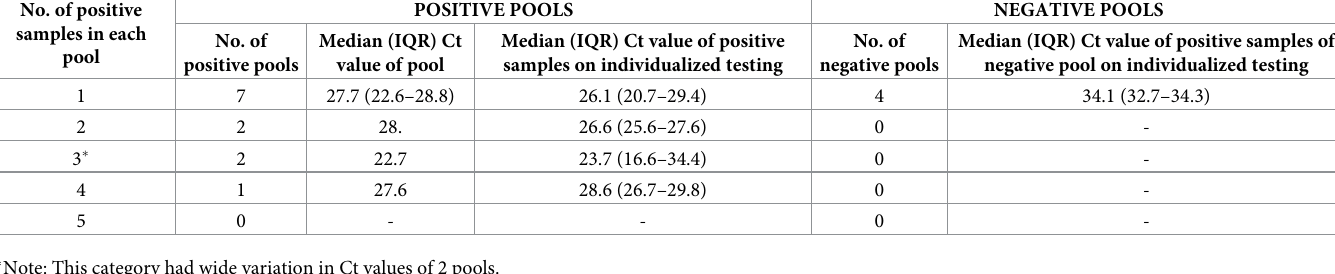
Table 1. Distribution of Ct values on pooled analysis of samples that tested positive on individualized testing.